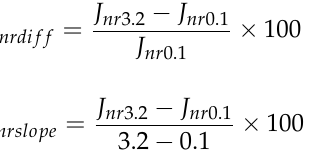
Figure 7. R% of asphalts and mastics at 60 °C.